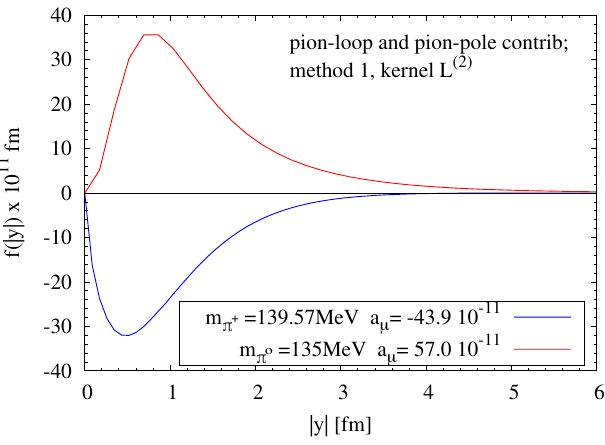
for the charged-pion loop µ